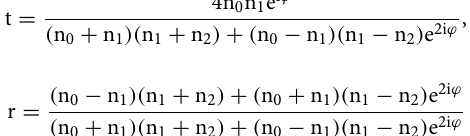
Figure 1. (a) Graphic description of the three-layer ultra-thin gold film, where a film of thickness h with complex refractive index n 1 = n m is embedded between n 0 and n 1 . (b) The dependence of conductivity on gold film thickness (the axis of the conductivity is in the log scale). Conductivities are calculated from supplementary information S1 Eq. (2), using the value of bulk conductivity of the thick gold film 4.1 × 10 yellow line). Absorbance varying thickness of the thin film gold optimized for normal-incidence absorption in free standing limit n 0 = n 2 = 1 where, (c) σ is the bulk conductivity, and (d) the conductivity defined by the ( b ) (the axis of the film thickness is in the log scale and dashed blue line indicate h = h 0